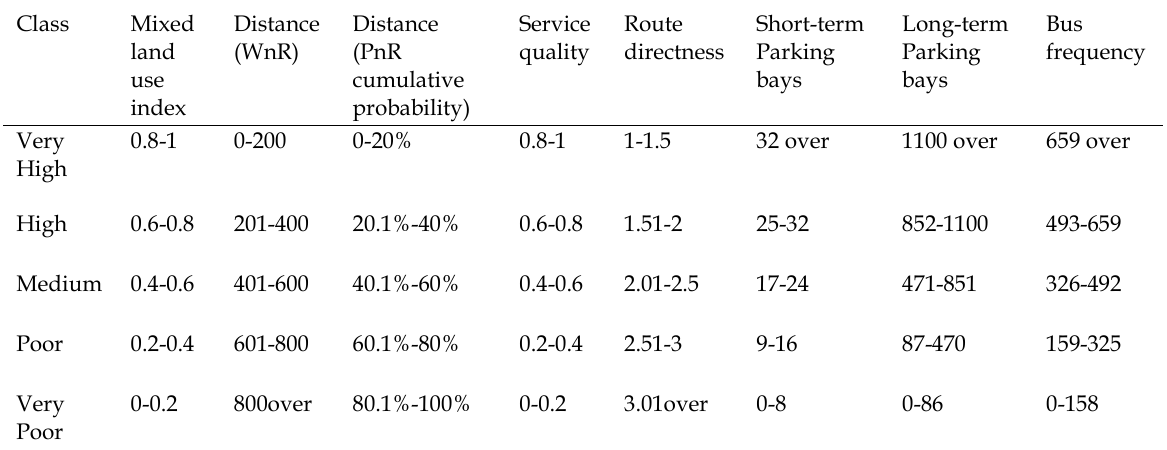
Figure 3. Cumulative Probability of Travel Distances to Greenwood Station. Table 3. Assignment of variables to a common class